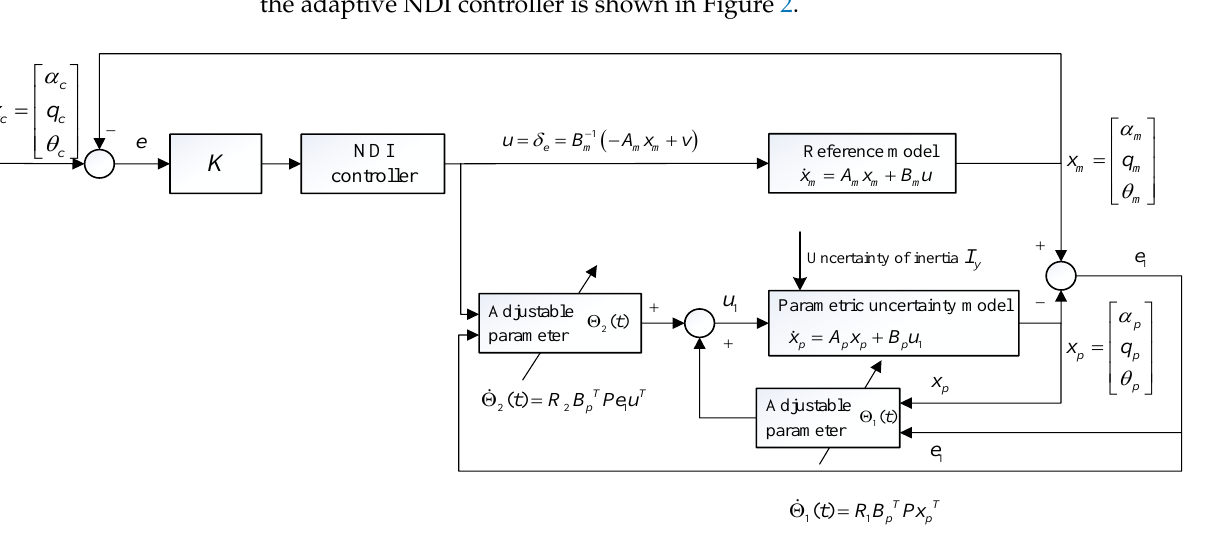
Figure 2. Adaptive NDI control structure diagram of longitudinal HFV model.